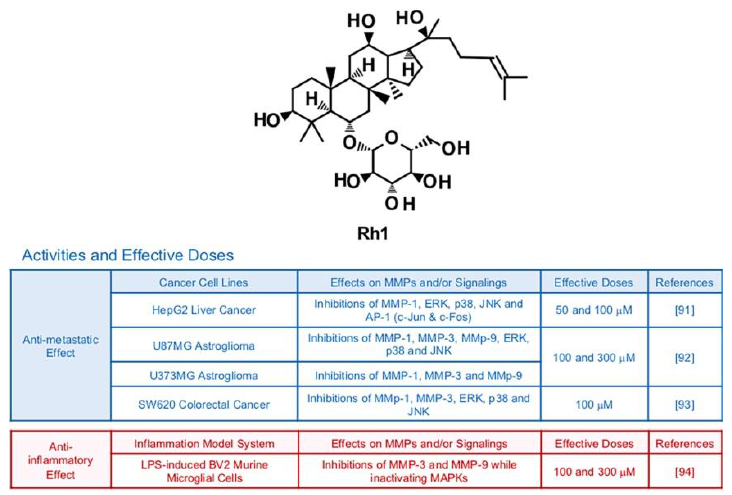
Figure 5. Summary of activities of ginsenoside Rh1. Structure of Rh1 and its effects on MMPs and/or signalings [91–94].